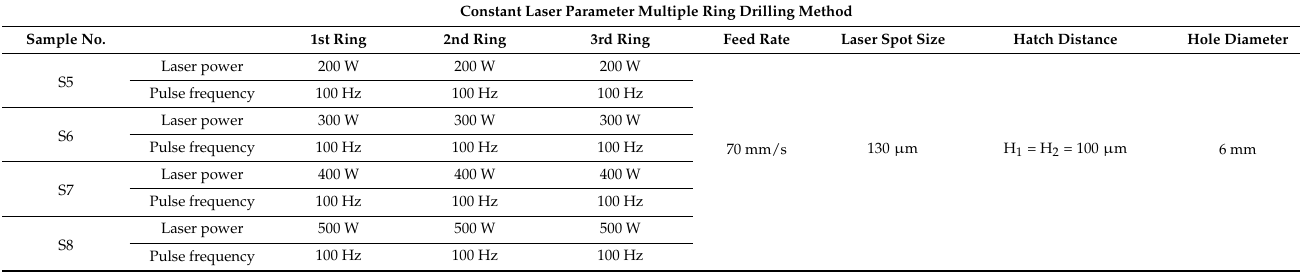
Table 2. Laser processing parameters for the constant laser parameter multiple-ring drilling method. ConstantLaserParameterMultipleRingDrillingMethod